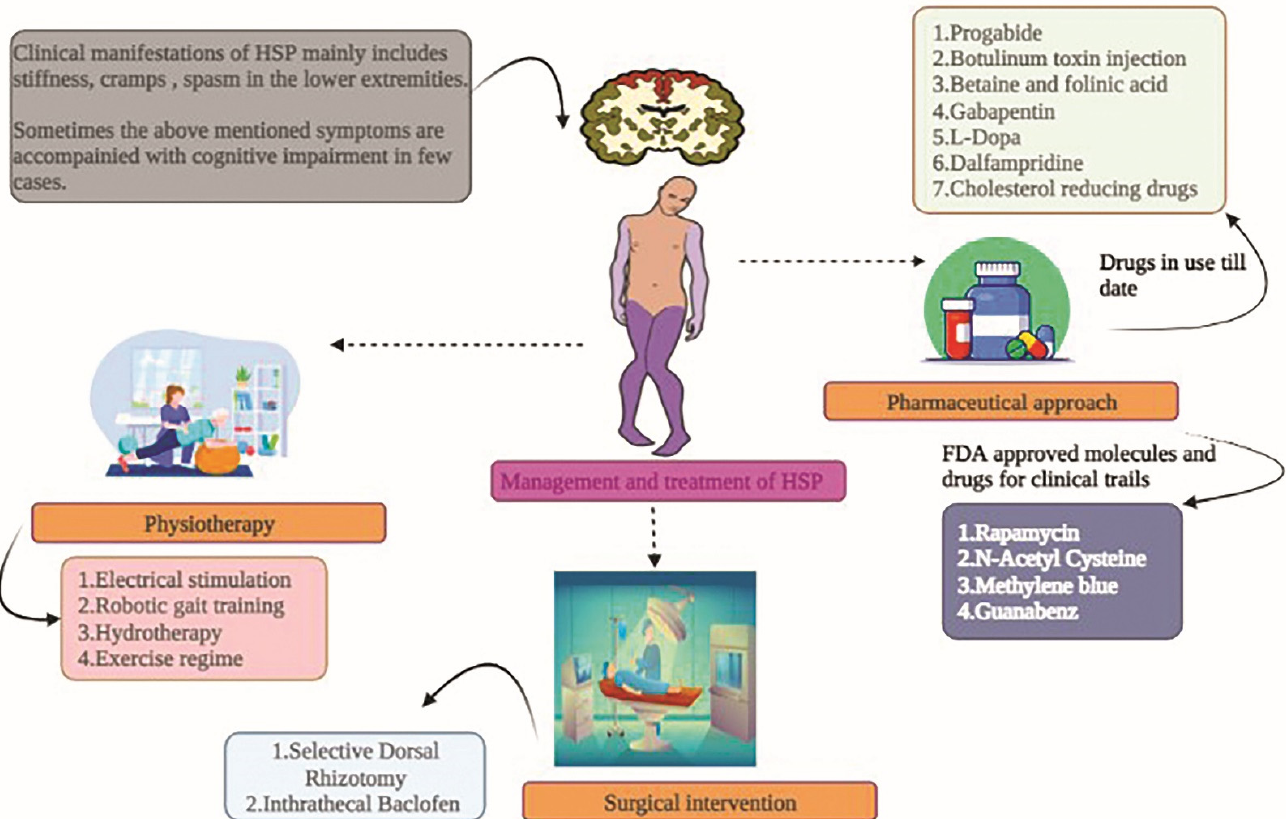
Figure 4. HSP patients have shown the clinical manifestations, and the treatment and management options available to date. The combination of physiotherapy and the pharmaceutical approach has been shown to provide good output. However, studies must be conducted on large cohorts to offer evident results to the management and therapeutic approach.